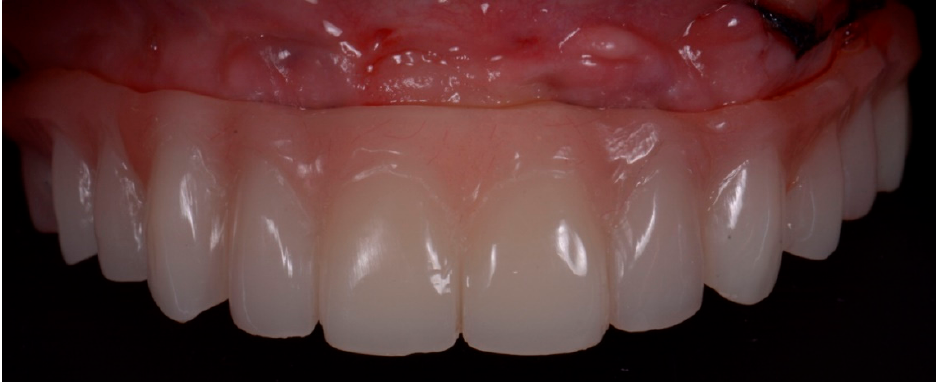
Figure 10. Adapted, relined and refined provisional prosthesis.